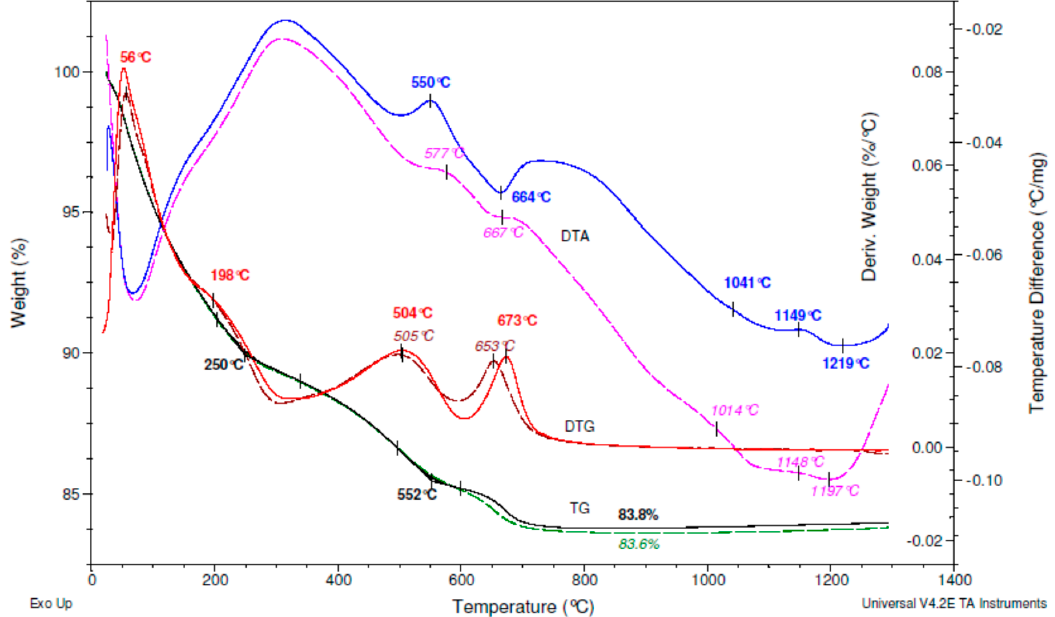
Figure 3. Thermogravimetric, Derivative Thermogravimetric, and Differential Thermal Analyses (TG-DTG-DTA) curves of ES-NH analyzed under flow of air (solid lines) or nitrogen (dashed lines).